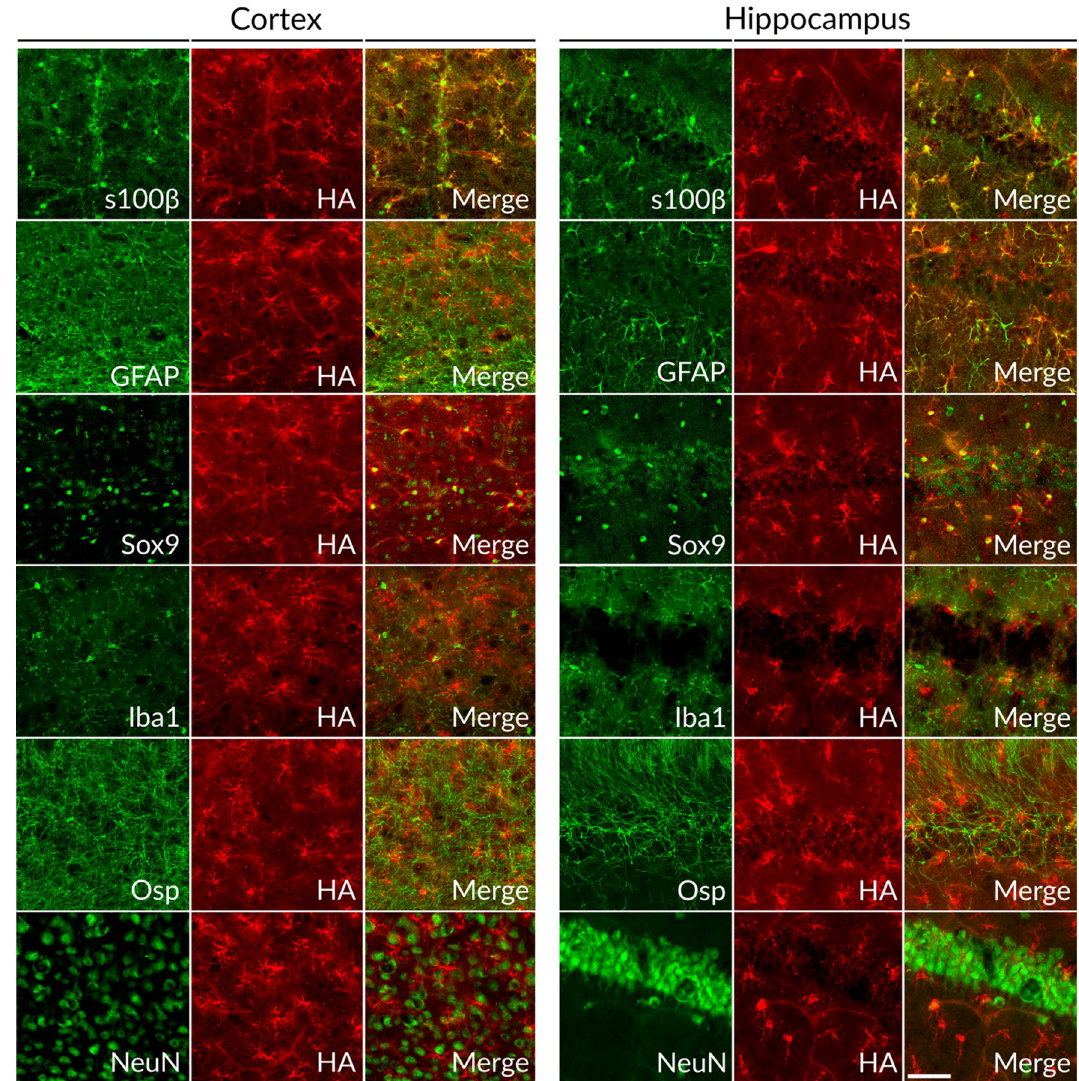
Figure 4. Immunofluorescence staining of Slc1a3-CreERT2::RiboTag mice. Representative images from hippocampus and cortex of 7 weeks old mice. RiboTag is a Cre reporter line that upon recombination leads to the expression of an HA (hemagglutinin)-tagged ribosome protein. For each marker, co-staining with anti-HA antibody (HA; RiboTag, red) was used to mark recombined cells; S100β calcium binding protein (astroglial marker), GFAP glial fibrillary acidic protein (astroglial marker), Sox9 SRY-Box Transcription Factor 9 (astroglial marker), Iba1 ionized calcium binding adaptor molecule (microglial marker), Osp oligodendrocyte surface protein, NeuN neuronal nuclei. Scalebar = 50